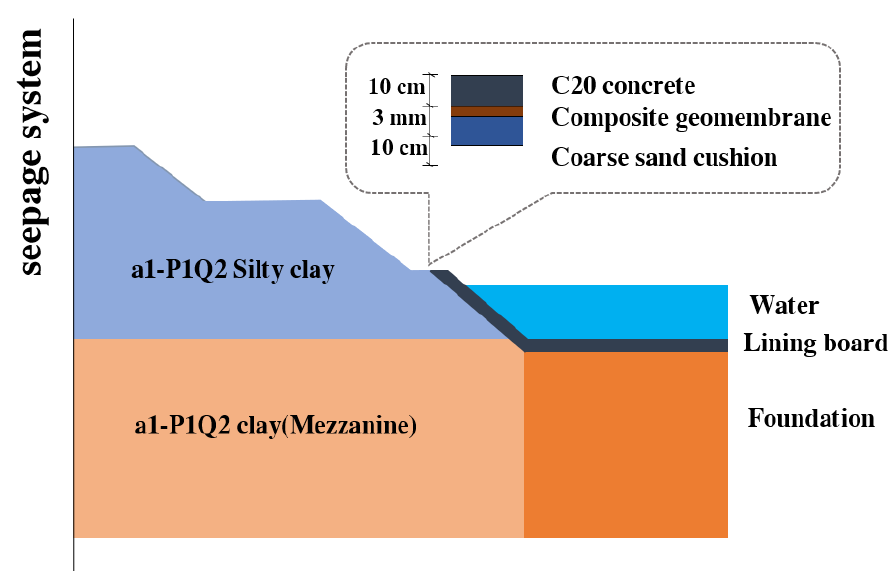
Three monitoring points, A, B, and C, were selected in the deep excavated canal to monitor the canal’s displacement and settlement. The clay materials are mainly used for the foundation and slope of the deep excavated canal section of the SNWDP. The anti-seepage system is mainly achieved by a concrete lining board, geomembrane, coarse sand cushion, and polysulfide sealant, as shown in Figure 5. During the actual operation of the SNWDP, the canal’s infiltrated surface is subject to the continuous change of the permeability coefficient. Therefore, in this study, the characteristics of the water section were constantly assumed to ensure the continuity and accuracy of the results.